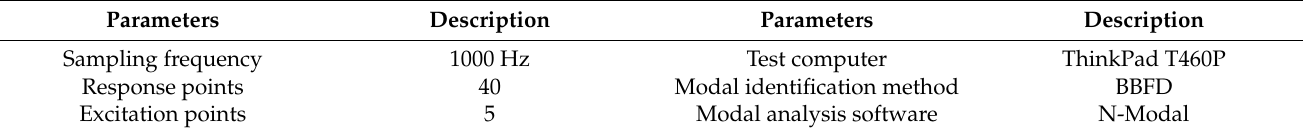
Table 2. Configuration parameters of the modal